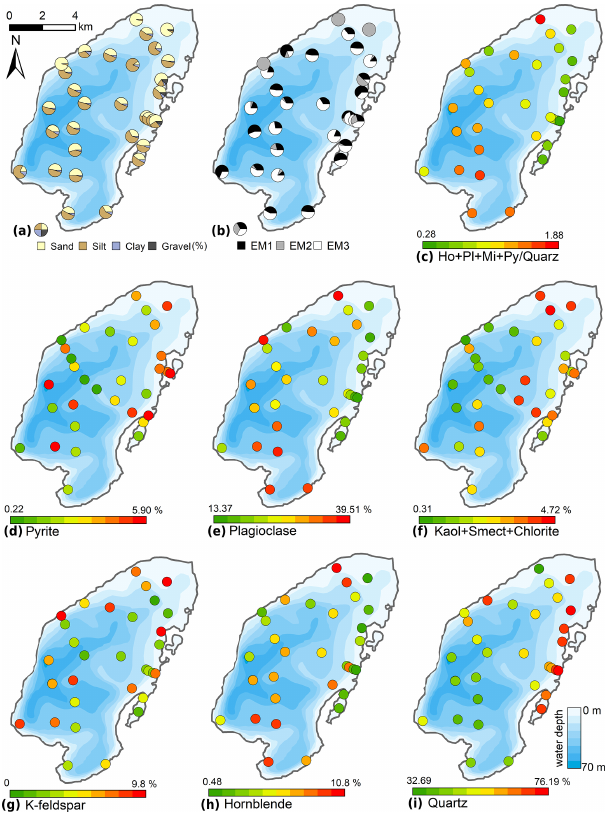
Figure 8. Spatial distribution of elements obtained from XRF mea- surements of surface sediments of Lake Bolshoe Toko. Maps com- piled in ArcGIS 10.4. Scales chosen as 10 classes with equal inter-